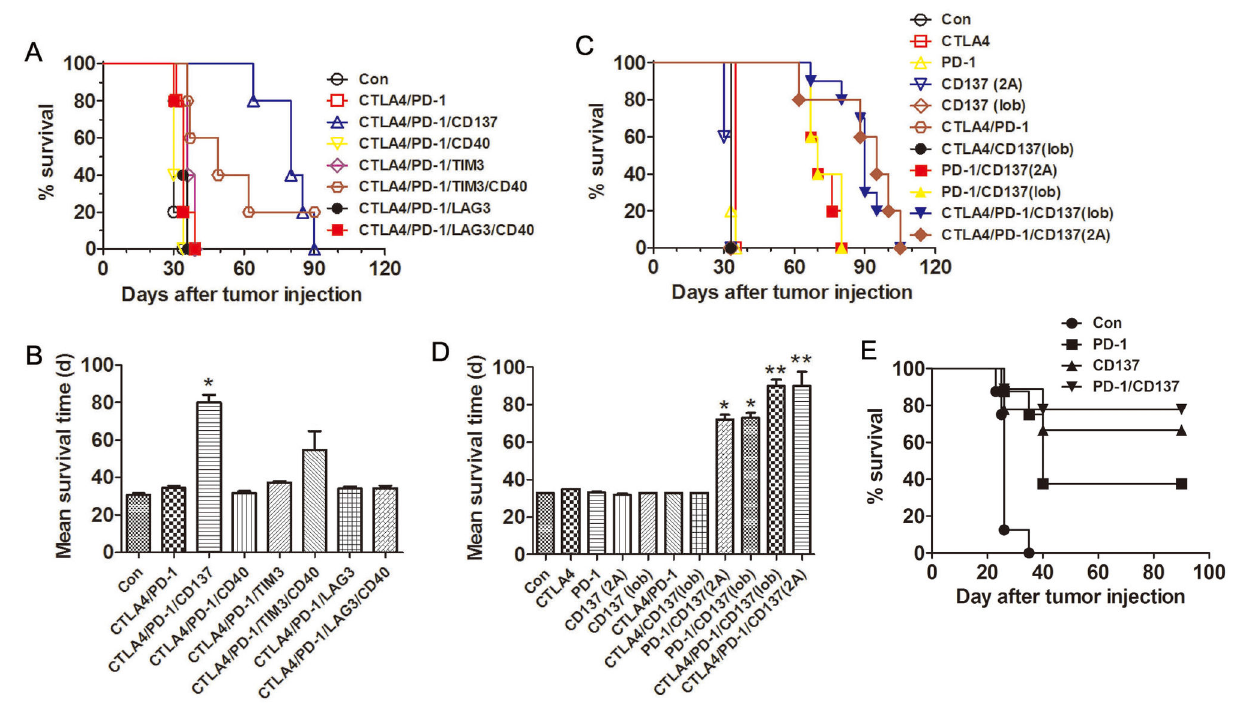
Figure 1. Antitumor effects of anti-CD137/PD-1 mAbs againstne ID8 ovarian cancer. Mice (5/group) transplanted i.p. with 3 × 10 6 ID8 cells 10 days previously were injected i.p. twice at 4 days interval with the indicated mAb combinations (0.5 mg of each mAb/mouse); survival was recorded (A, C) and mean survival time was calculated (B, D). The experiment was repeated once with similar results. E, Mice (8-9/group) transplanted i.p. with 3 × 10 6 ID8 cells 3 days previously were injected i.p. twice at 4 days interval with 0.5 mg of control, anti-PD-1, anti-CD137 and anti-PD-1/CD137 mAb and their survival was recorded. *P < 0.05, **P < 0.01, compared with control mAb treated